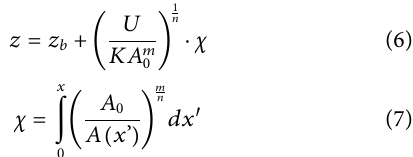
Frontiers in Earth Science |